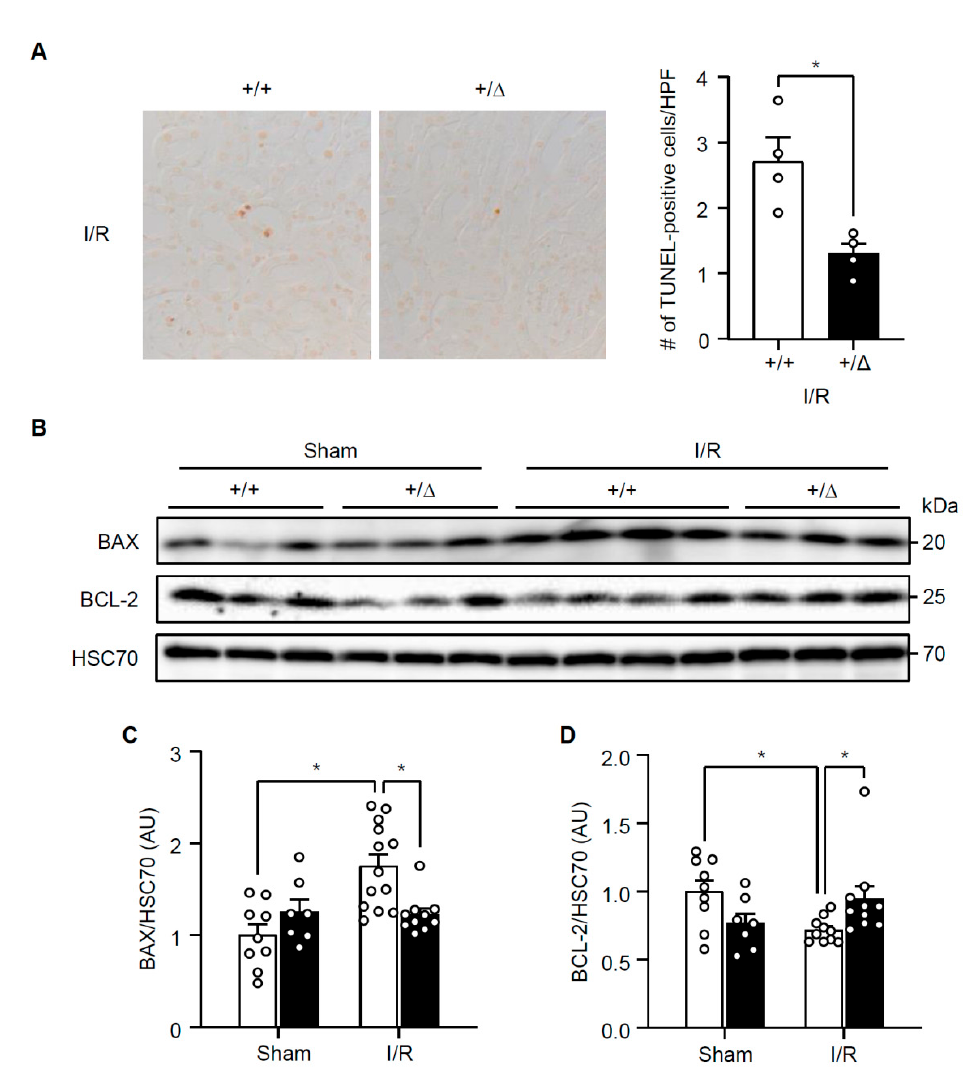
Figure 3. Renal apoptosis and expression of apoptotic proteins in TonEBP +/ Δ (+/ Δ , filled bars) mice and their TonEBP +/+ littermates (+/+, open bars) after I/R or sham treatment of kidneys. ( A ) Kidney sections were stained for TUNEL. TUNEL-positive cells were counted and expressed as number per high power field (HPF), ( B ) Renal cortices were immunoblotted for Bax, Bcl-2, and Hsc70, ( C , D ) Ratio of band intensity, Bax / Hsc70, and Bcl-2 / Hsc70, was calculated and shown in arbitrary unit (AU). Mean + SEM, * p < 0.05.